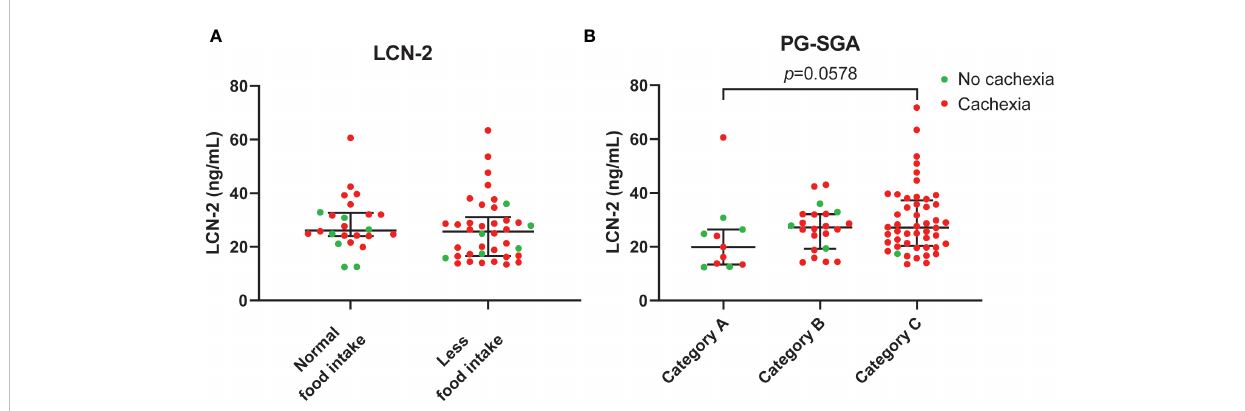
FIGURE 7 Circulating LCN-2 levels in PDAC patients according to food intake and nutritional status. Comparison of systemic levels of LCN-2 in PDAC patients with normal versus reduced food intake (A) . LCN-2 levels in plasma from well-nourished (category A), moderately malnourished (category B), and severely malnourished (category C) PDAC patients (B) . Scatter plots showing the median + IQR and individual data points in each group. For statistical analysis, the Mann – Whitney U test was used for two groups and the Kruskal-Wallis test followed by Dunn ’ s post-testing for analysis of multiple